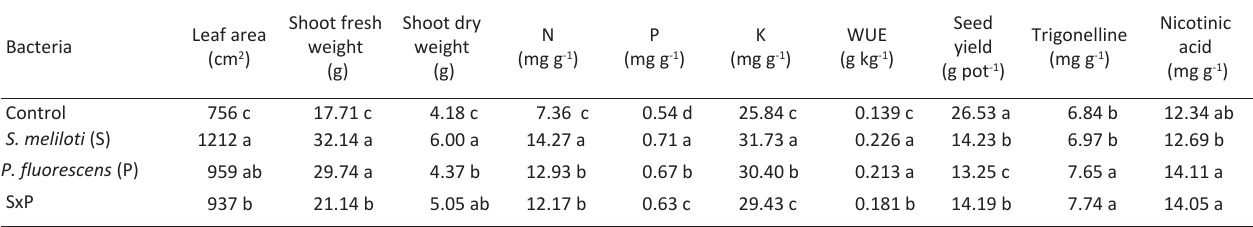
SxP= treatment containing both S. meliloti and P. fluorescens .